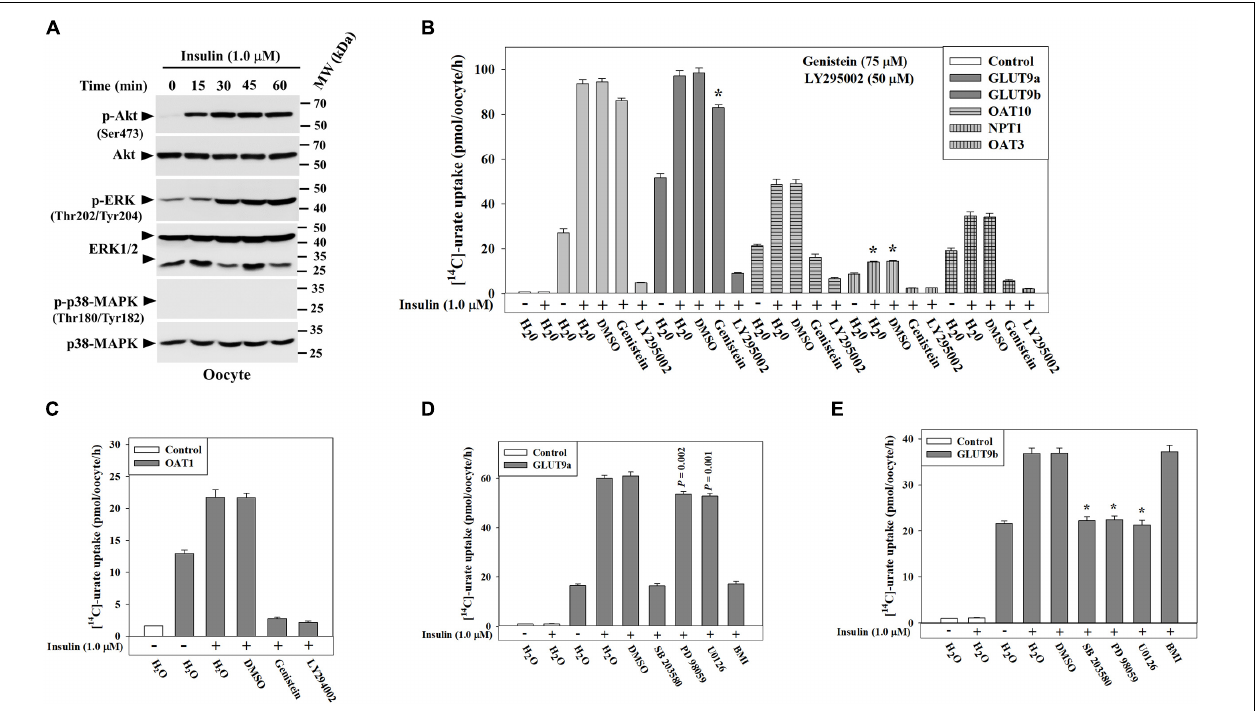
FIGURE 5 | Insulin stimulates urate transport activity of GLUT9 isoforms, OAT10, NPT1, OAT3 or OAT1 in Xenopus oocytes via activation of protein tyrosine kinase (PTK) activity of INSR, phosphatidylinositol 3-kinase (PI3K), Akt, and/or p44/42 MAPK (ERK). (A) Western blot analyses of the lysates of Xenopus oocytes, treated with insulin (1.0 µ M) at ∼ 25 ◦ C in K + -free isotonic medium using appropriate antibodies for indicated antigens. (B,C) The stimulatory effect of insulin (1.0 µ M) on [ 14 C]-urate uptake mediated by GLUT9 isoforms, OAT10, NPT1, mouse OAT3 and OAT1 in Xenopus oocytes was measured in the absence and presence of the natural PTK inhibitor (genistein; 75 µ M) or PI3K inhibitor (LY 294002; 50 µ M). Oocytes expressing OAT10 or NPT1 were preloaded with nicotinate (Nico) by microinjection of 50 nl of 100 mM nicotinate 2h before urate uptake. (D,E) Insulin-stimulation of urate uptake activities of human GLUT9a or GLUT9b was examined in oocytes in the absence and presence of p38 MAPK inhibitor (SB 203580; 10 µ M), MEK/ERK inhibitor (PD 98059/U0126; 20 µ M) or protein kinase C inhibitor (bisindolylmaleimide I hydrochloride, or BMI; 10 µ M) in K + -free isotonic medium. Asterisk (*), P < 0.001 compared with urate uptake in the presence of insulin and